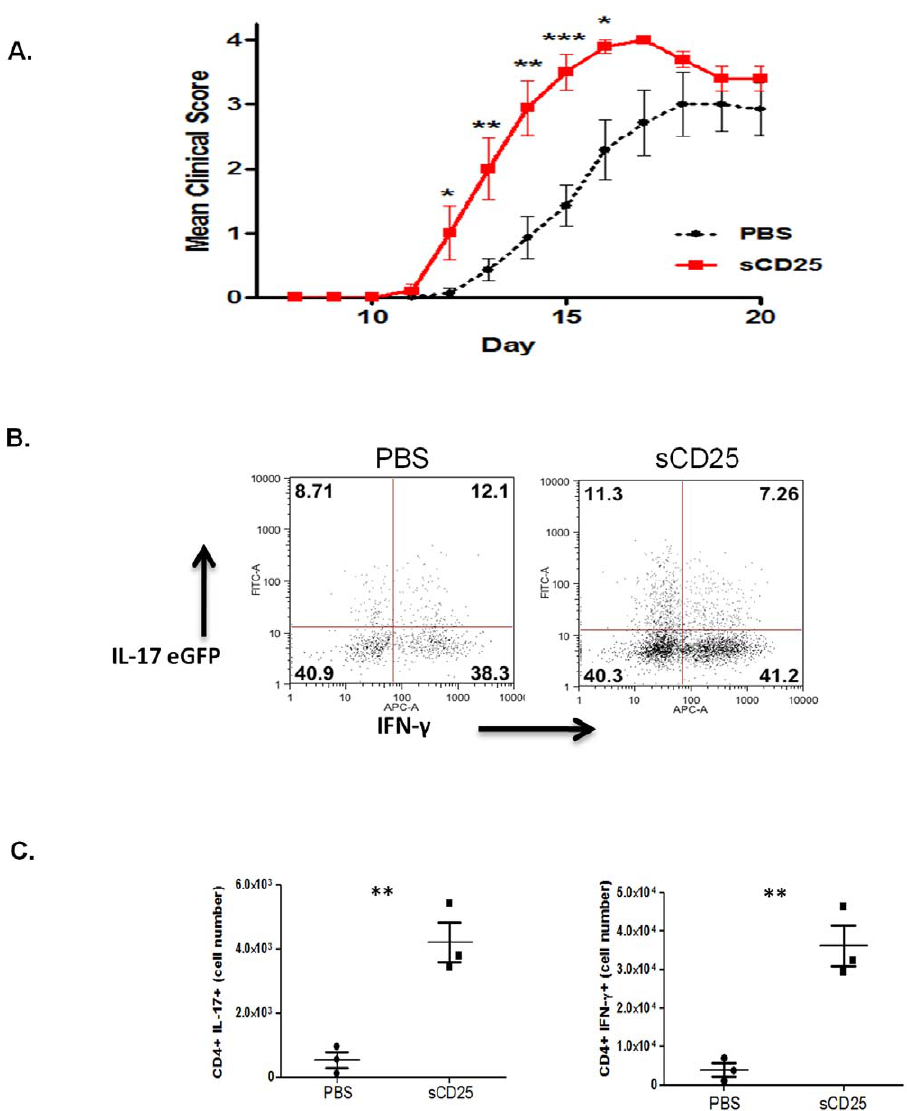
Figure 1. Exogenous sCD25 exacerbates autoimmunity. ( A ) MOG 33 2 55 immunized C57BL/6 mice developed clinical symptoms of EAE from day 12 after immunization with a peak of disease severity observed from day 19. Subcutaneous administration of recombinant sCD25 (25 m g/mouse) immediately prior to immunization and every 12 hours thereafter for 72 hrs resulted in a significant exacerbation in severity of symptoms during disease onset and induction. 6–7 mice used per group. ( B ) Mononuclear cells harvested from spinal cords of control (PBS) and sCD25 treated IL-17A- eGFP reporter mice (3 per group) on day 15 after immunization and analysed for expression of IL-17 and IFN- c by CD4 + cells. ( C ) Cell numbers of CD4 + IL-17 + and CD4 + IFN c + cells in spinal cords of IL-17A-eGFP reporter mice at day 15. Data representative of mean + / 2 std dev of 3 mice per group and 2 independent experiments. doi:10.1371/journal.pone.0047748.g001 AAD, under these conditions (Figure 3D). However, consistent (Figure 3A). In contrast, no effects of sCD25 were observed on the with the enhanced generation of a Th17 response, we also generation of either Th1 or inducible Treg subsets (Figure 3 A, B observed increased levels of phosphorylation of STAT3 & C). As Th17 cells are considered critical in driving the (Figure 3E). sCD25 also led to a marginal but reproducible pathogenesis of EAE, these data are consistent with our earlier in vivo data (Figure 1). We also examined what influence sCD25 may increased expression of both IL-17F and the Th17 associated chemokine receptor CCR6, while levels of IL-22 expression were have on Th17 cell proliferation and survival as IL-2 is a well not affected (data not shown). These data clearly demonstrate that established T cell growth factor and we observed an increase in the sCD25 can enhance Th17 cell development in vitro and suggest overall numbers of infiltrating CD4 + T cells in the spinal cords of a mechanism through which sCD25 may increase autoimmune treated mice (Figure 1C), Although sCD25 resulted in an increase disease severity. in the proportion of cells expressing IL-17A, it did not affect either the rate of cell division as determined by levels of CFSE dilution, or levels of survival/cell death, as measured by incorporation of 7-